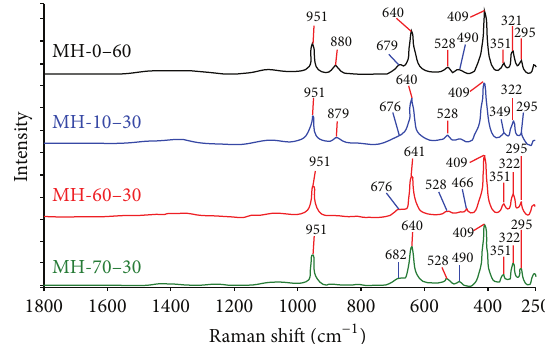
Figure 5: Raman spectrum of synthesized pure mcallisterite miner- als.